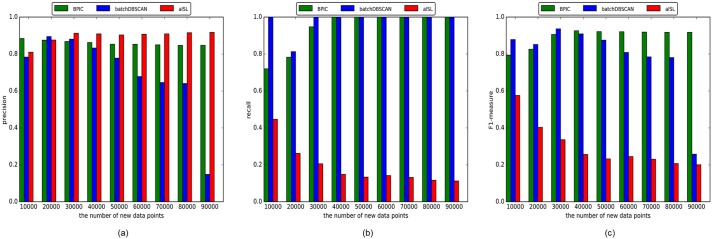
The evaluations of incremental clustering results by the three methods with different numbers of new points.(a)Precision of incremental clustering results. (b) Recall of incremental clustering results. (c) F1-measure of incremental clustering results.